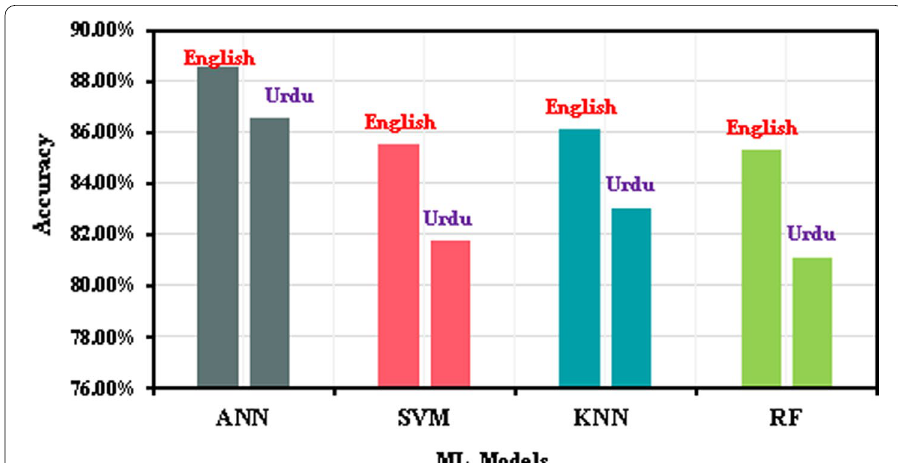
Fig. 6 The accuracy of the classification models with TFCV for English and Urdu Dataset